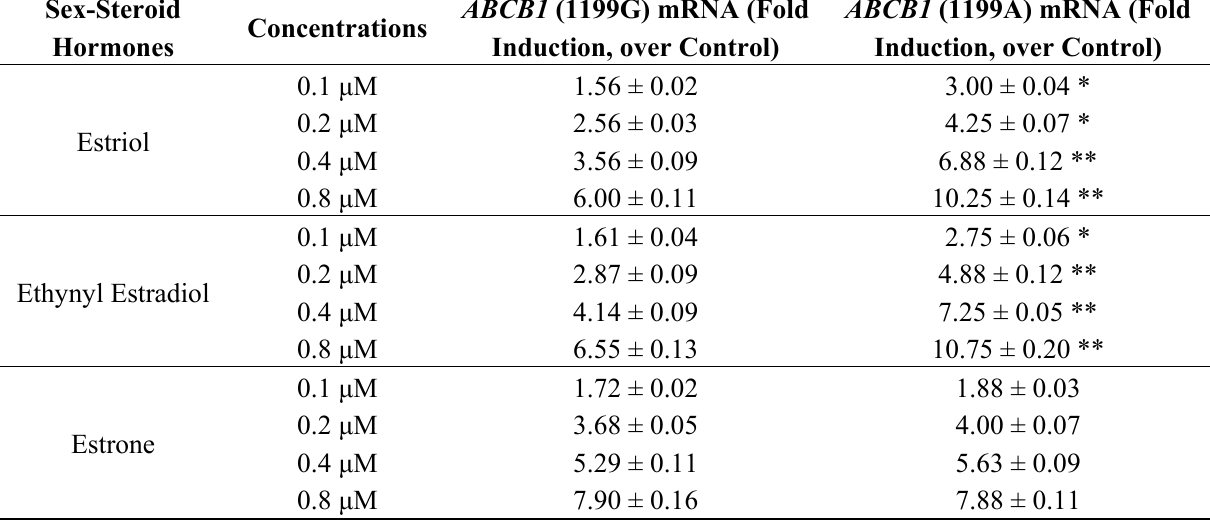
Table 1. Quantitation of steroid sex hormone-induced up-regulation of ABCB1 (1199G) and ABCB1 (1199A)